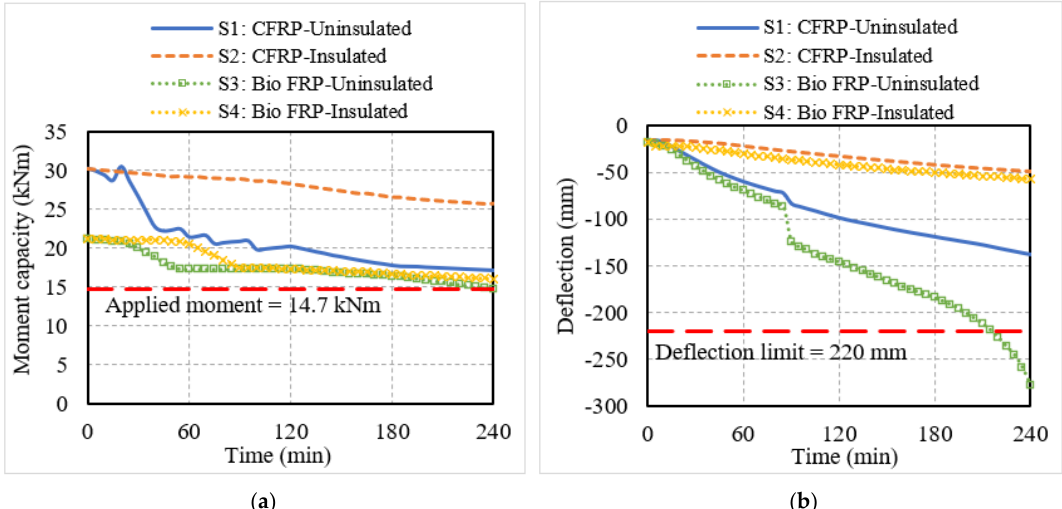
Figure 8. Structural response of slabs strengthened with conventional or bio-based NSM FRP rein- forcement. ( a ) Moment capacity; ( b ) mid-span deflection.